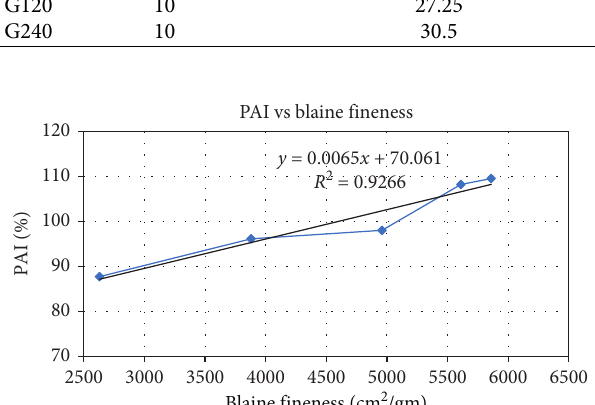
Figure 17: Relationship between PAI and Blaine